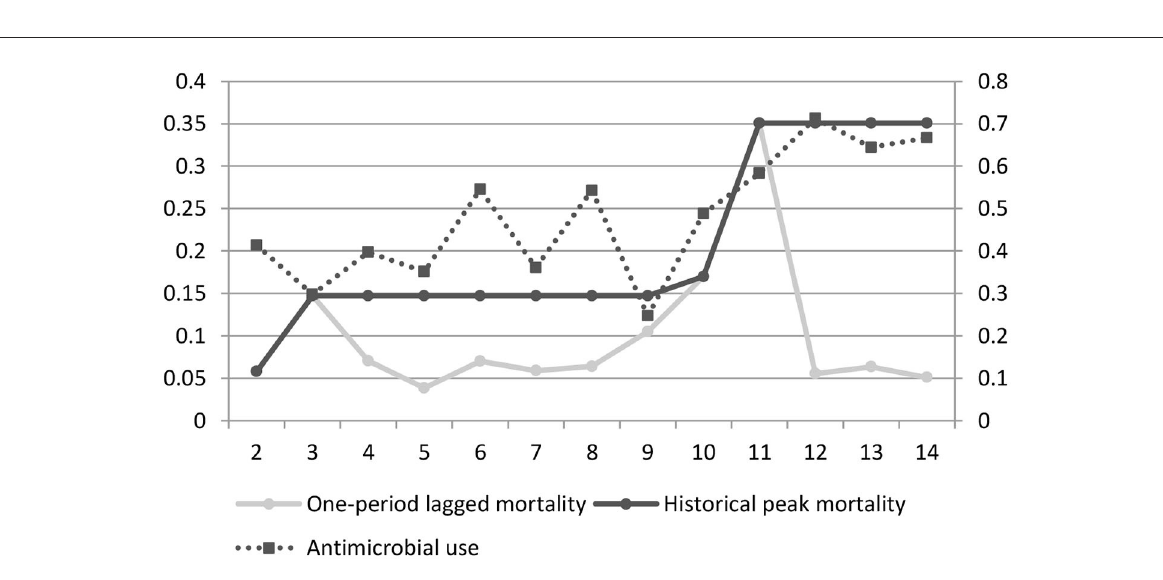
Fixed effects of broiler breed, chick-receiving month, and chick- receiving year were also included in the model to